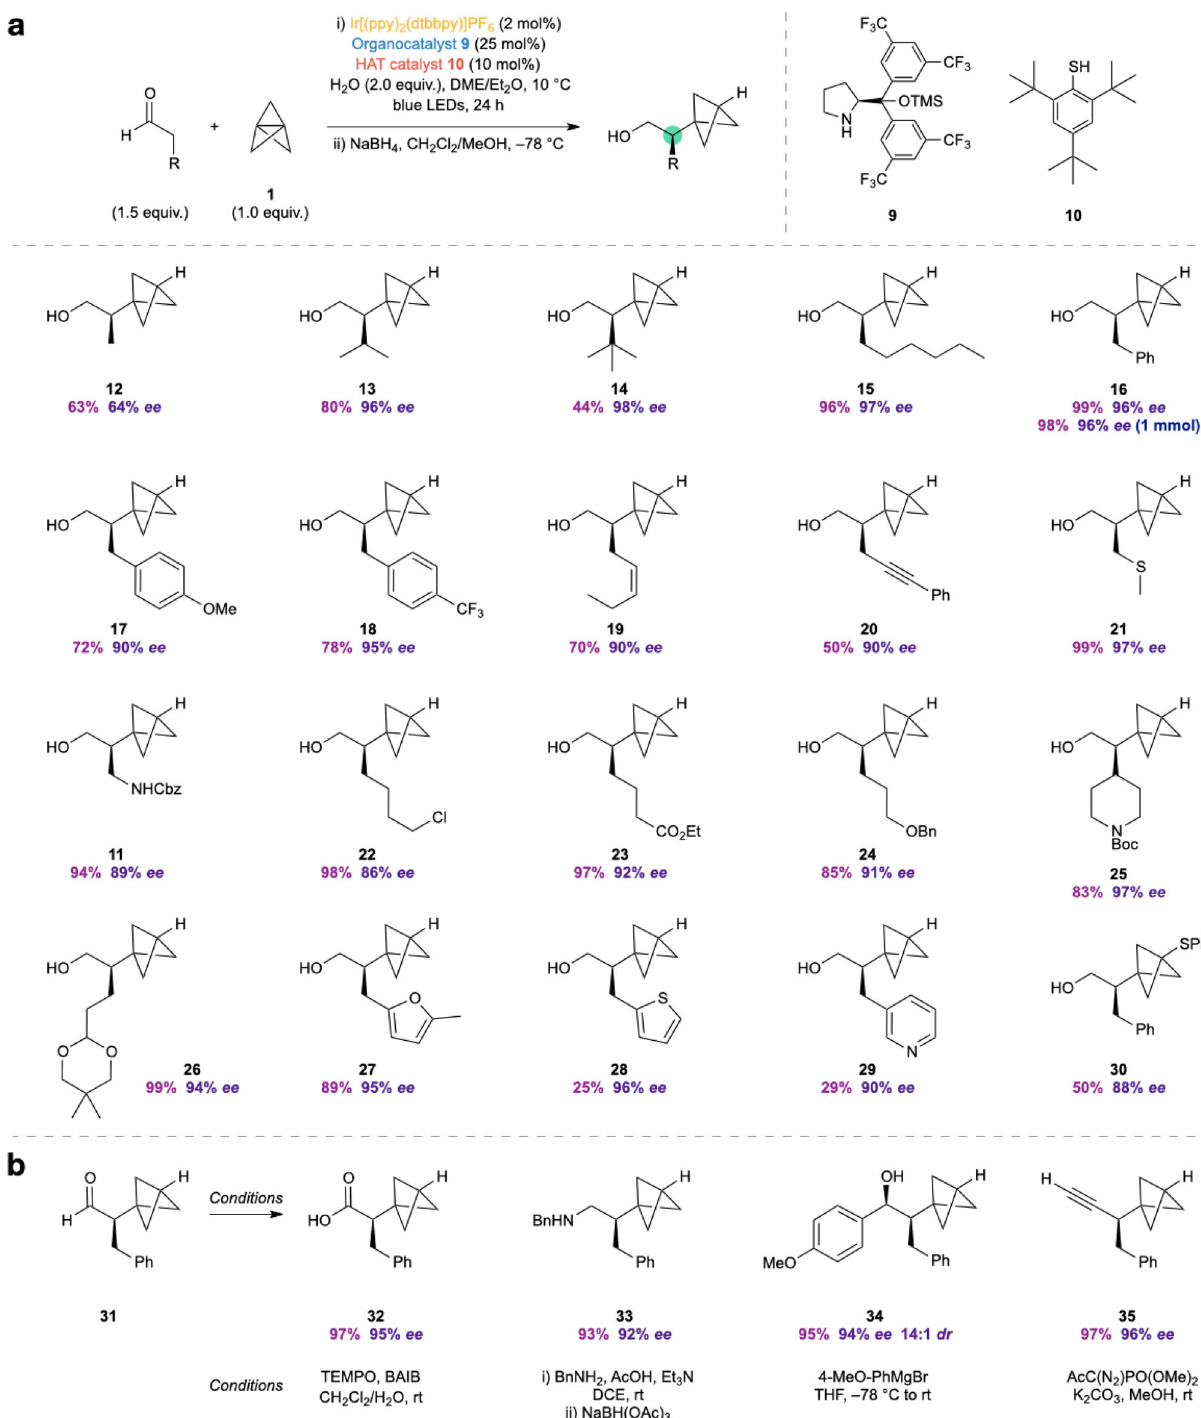
Fig. 4 Scope of the reaction and product derivatization. a The catalytic asymmetric synthesis of α -chiral BCPs displays a wide substrate scope and functional group tolerance, affording enantioenriched BCP products in high yields and enantioselectivities. b The aldehyde product can be derivatized to a range of other high-value chiral BCP building blocks. The absolute stereochemistry of 12 was assigned by comparison of supercritical fl uid chromatography (SFC) data of a derivative with its enantiomer 30 ; other products were assigned by analogy. See Supplementary Information, Section 3.2.2 for details. TEMPO = (2,2,6,6-tetramethylpiperidin-1-yl)oxyl; BAIB = PhI(OAc) 2 ; DCE =